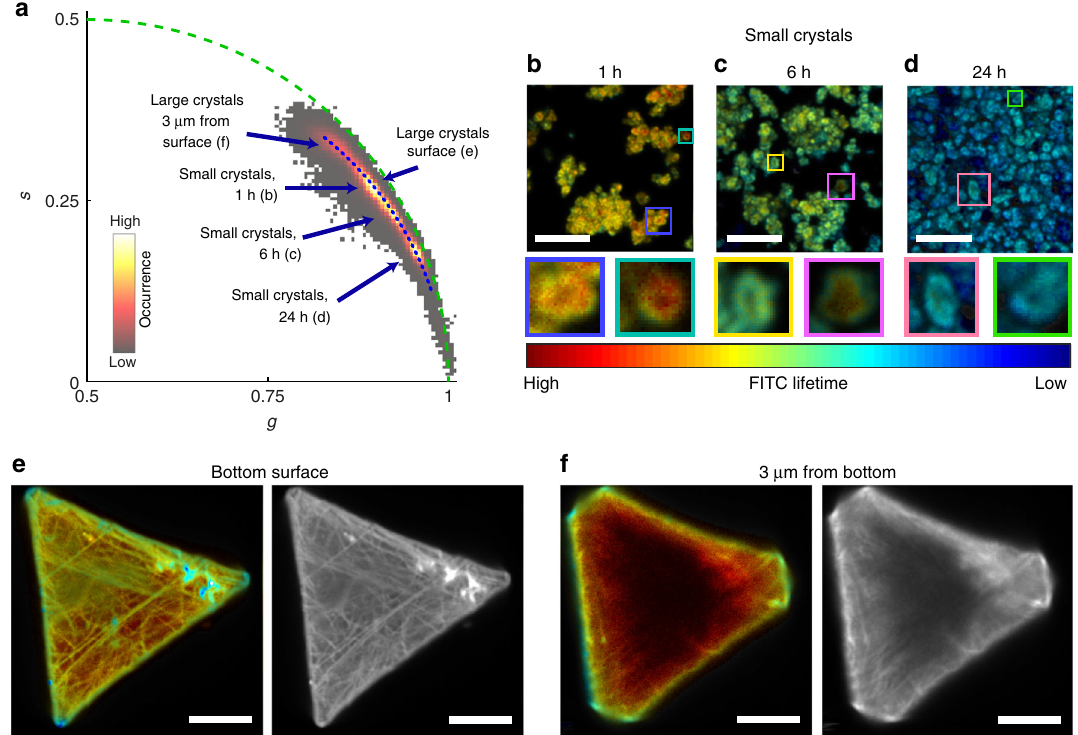
Fig. 4 Phasor FLIM data of UiO-67 samples functionalized with FITC using linker exchange. a A phasor plot of the images shown in b – f . The blue arrows point at the average phasor positions of the different samples. b – d FLIM images of small crystal UiO-67 samples subjected to linker exchange with FITC- modi fi ed linkers at 65 °C for 1 h ( b ), 6 h ( b ), and 24 h ( c ). The inserts below are magni fi cations of the colored squares. e , f FLIM (in color) and fl uorescence intensity (in gray scale) images of large crystal UiO-67 samples subjected to linker exchange with FITC-modi fi ed linkers for 24 h. e An image recorded at the bottom surface of a crystal. f An image recorded inside the crystal, 3 µ m up from the bottom surface. The color coding of the images is based on the blue dotted line in panel a using the color table shown in b . The scale bar of all images is 10 µ